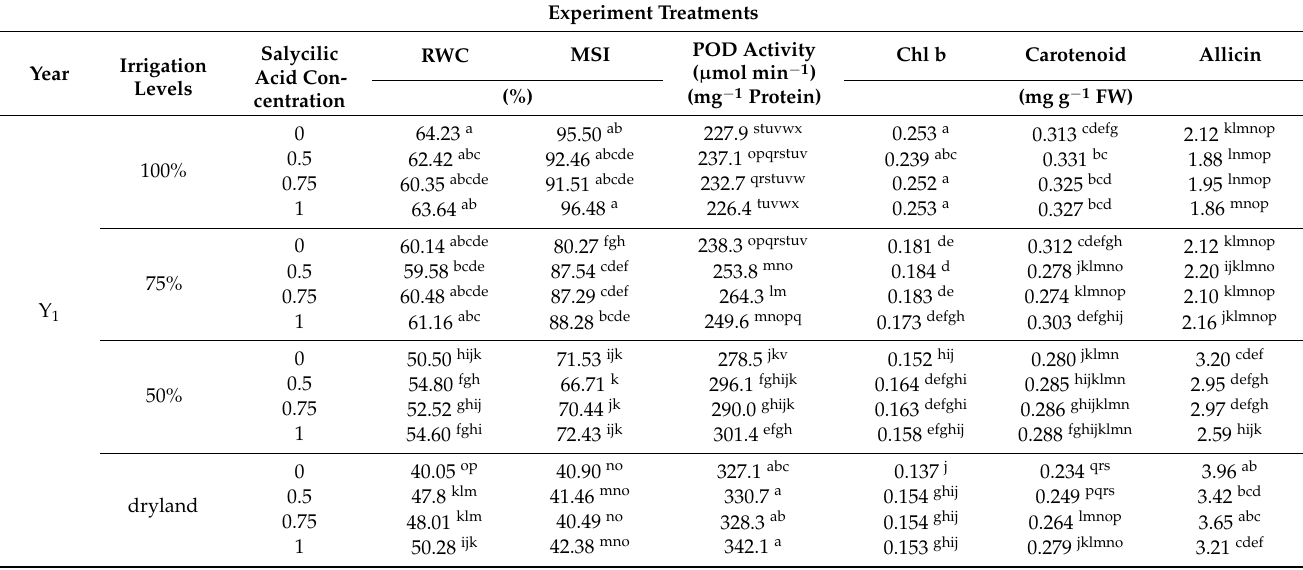
Table 3. Comparison of the mean triple interaction of irrigation levels (100, 75, and 50% of plant water requirement and non-irrigation), salicylic acid foliar application (non-application, 0.5, 0.75, and 1 mmol) and year (2016, 2017, and 2018) on the studied physiological traits in A. hirtifolium . Experiment